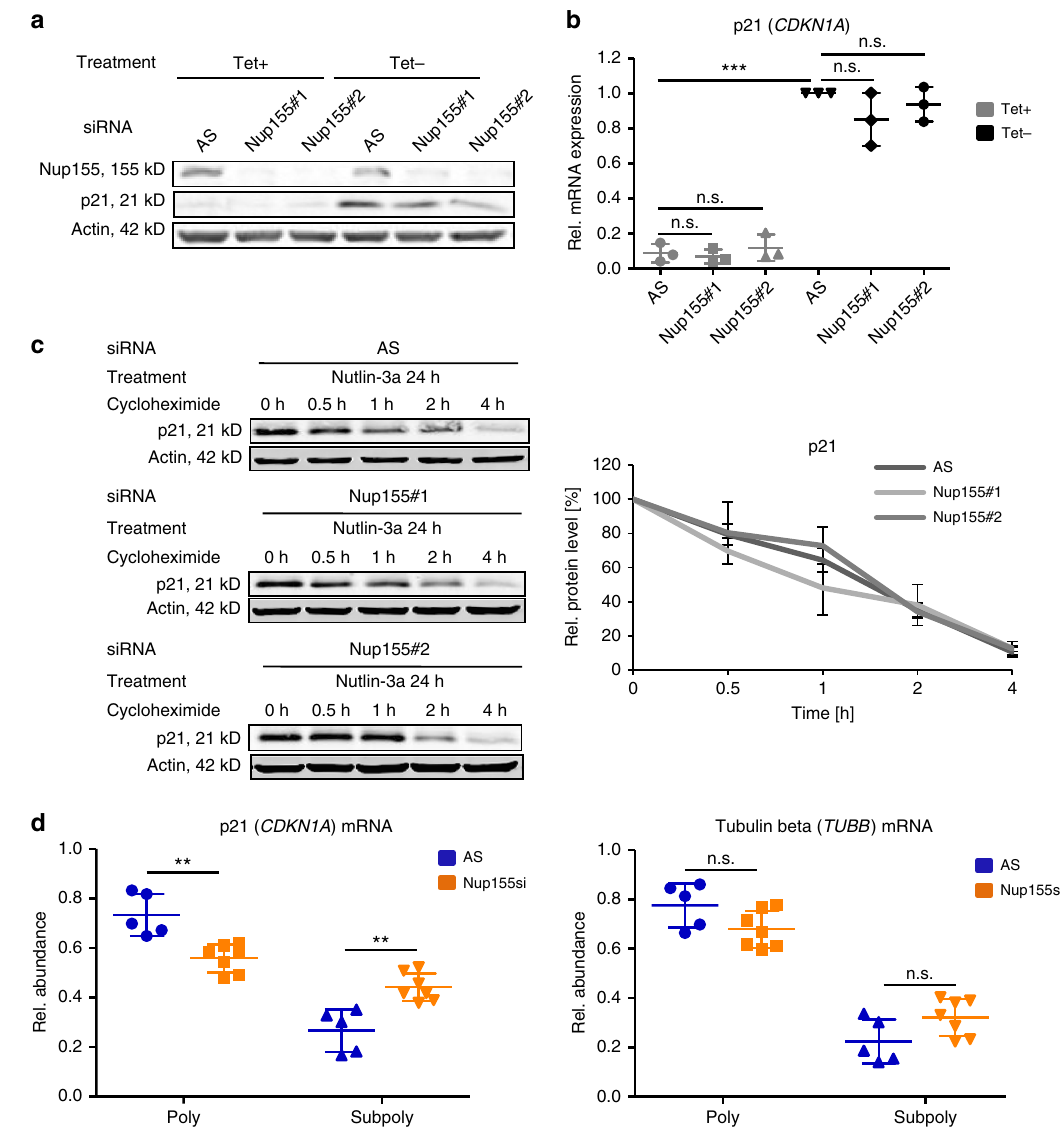
Fig. 2 Nup155 is involved in p21 mRNA translation. a H24-p21 cells containing a tetracycline (Tet-off)-regulatable p21 expression construct were either treated with control siRNA (AS) or two different Nup155 siRNAs (Nup155#1 and Nup155#2) for 72 h. p21 was induced by tetracycline (Tet) removal 96 h before harvesting. Cell extracts were analysed by immunoblotting with the indicated antibodies. For corresponding densitometric analyses see Supplementary Figure 2A. b Relative p21 ( CDKN1A ) mRNA levels of the corresponding conditions described in a were measured by qRT-PCR. Data are derived from three independent experiments and normalised to the Tet-off control siRNA (AS) condition. c HepG2 cells were treated either with control siRNA (AS) or two different Nup155 siRNAs (Nup155#1 and Nup155#2) for 72 h. p21 was induced by adding Nutlin-3a 24 h before blocking translational elongation with cycloheximide. Cells were harvested at indicated time points and analysed by immunoblotting with the indicated antibodies (left panels). Densitometric quanti fi cation analyses of the above-mentioned p21 half-life experiments normalised to the control siRNA condition (right panel). d HepG2 cells were treated either with control siRNA (AS) or two different Nup155 siRNAs for 72 h. Translational elongation was blocked with cycloheximide and polyribosome analyses were performed. p21 (left panel) and tubulin beta mRNA (right panel) of the polysomal (poly) and subpolysomal (subpoly) fractions were measured by qRT-PCR with the expression levels normalised to Renilla spike-in RNA. p -values result from the comparison of the control (AS) ( n = 5) and combined Nup155 siRNAs ( n = 7), see also Methods section. ** p < 0.01, *** p < 0.001 (Student ′ s t -test); Data are presented as mean ± stdv.